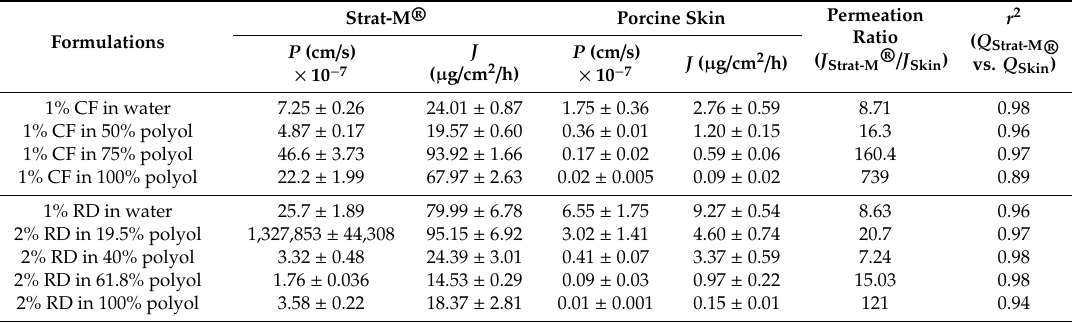
Table 2. Permeation parameters of CF and RD from various formulations through Strat-M ® and porcine skin under infinite dose